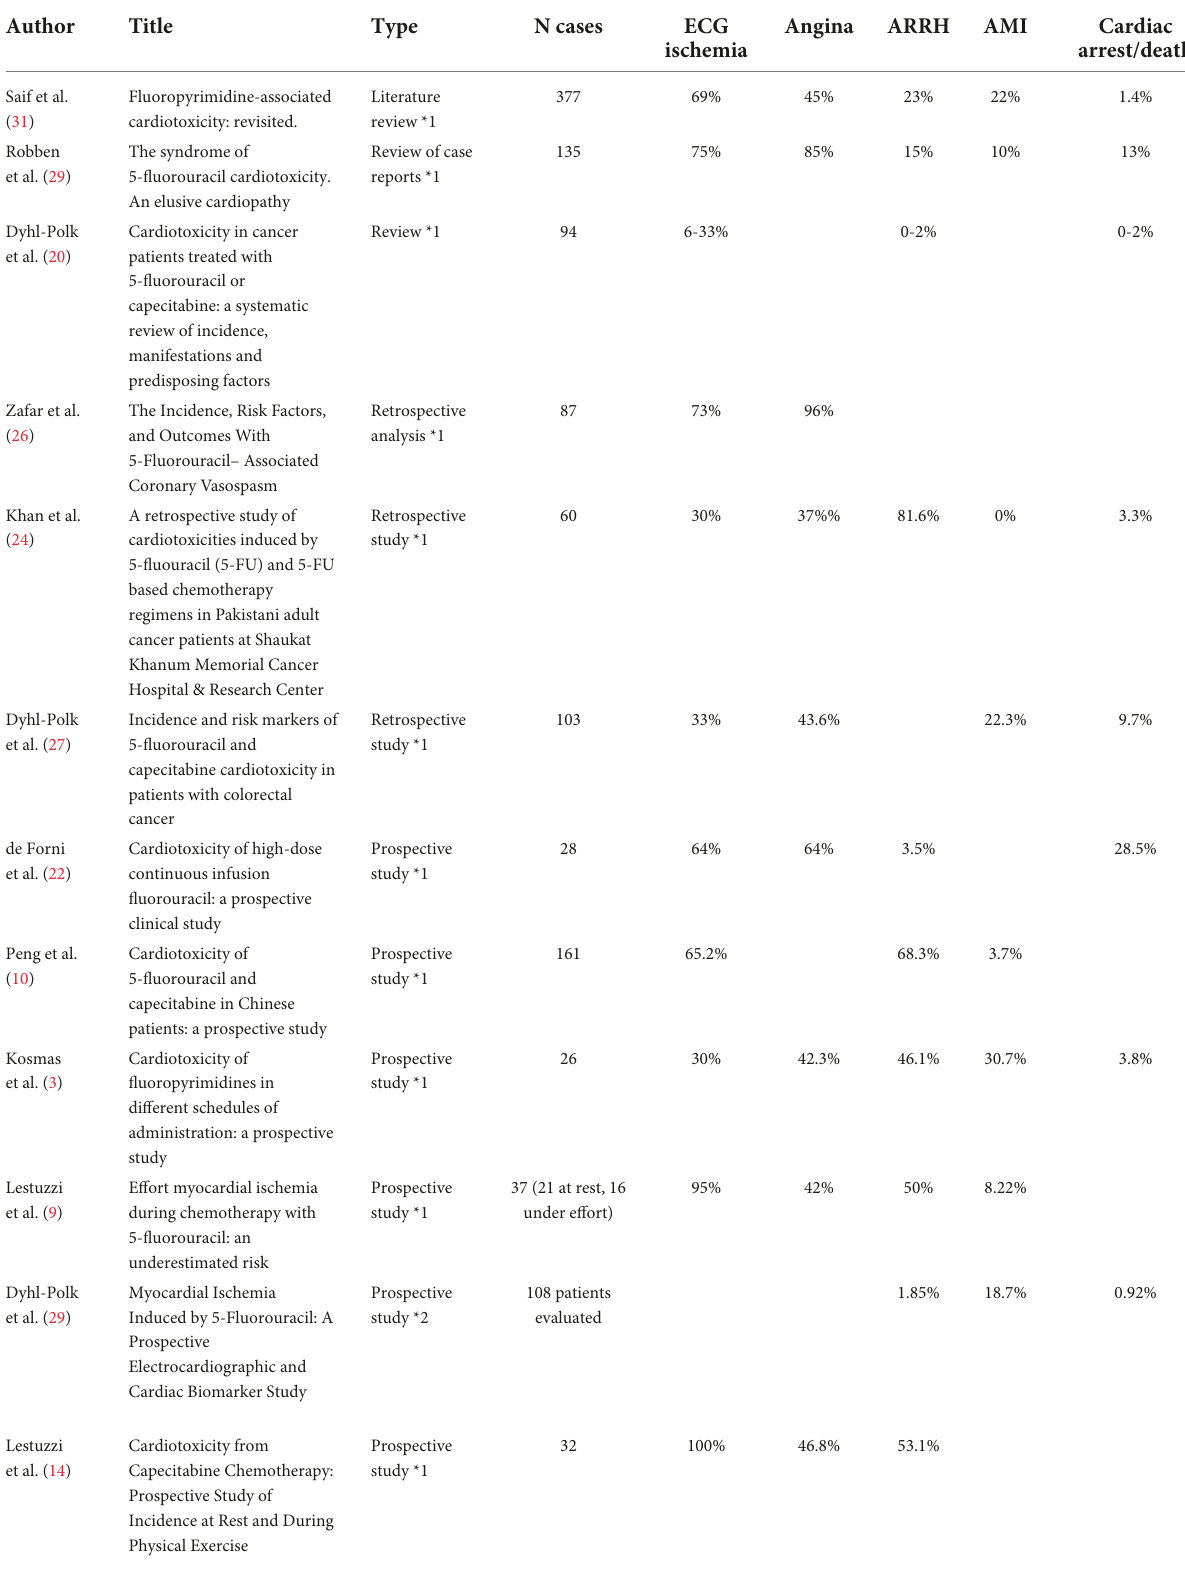
TABLE 1 Fluoropyrimidine Cardiotoxity reported in the